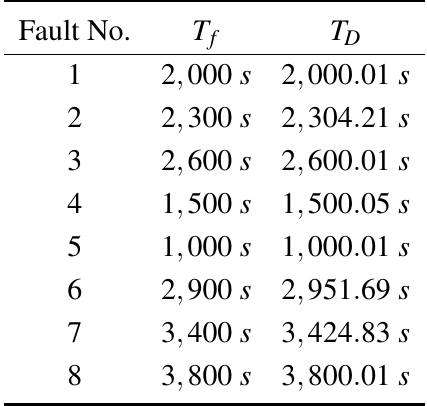
Table 6. Summary of fault detection results.